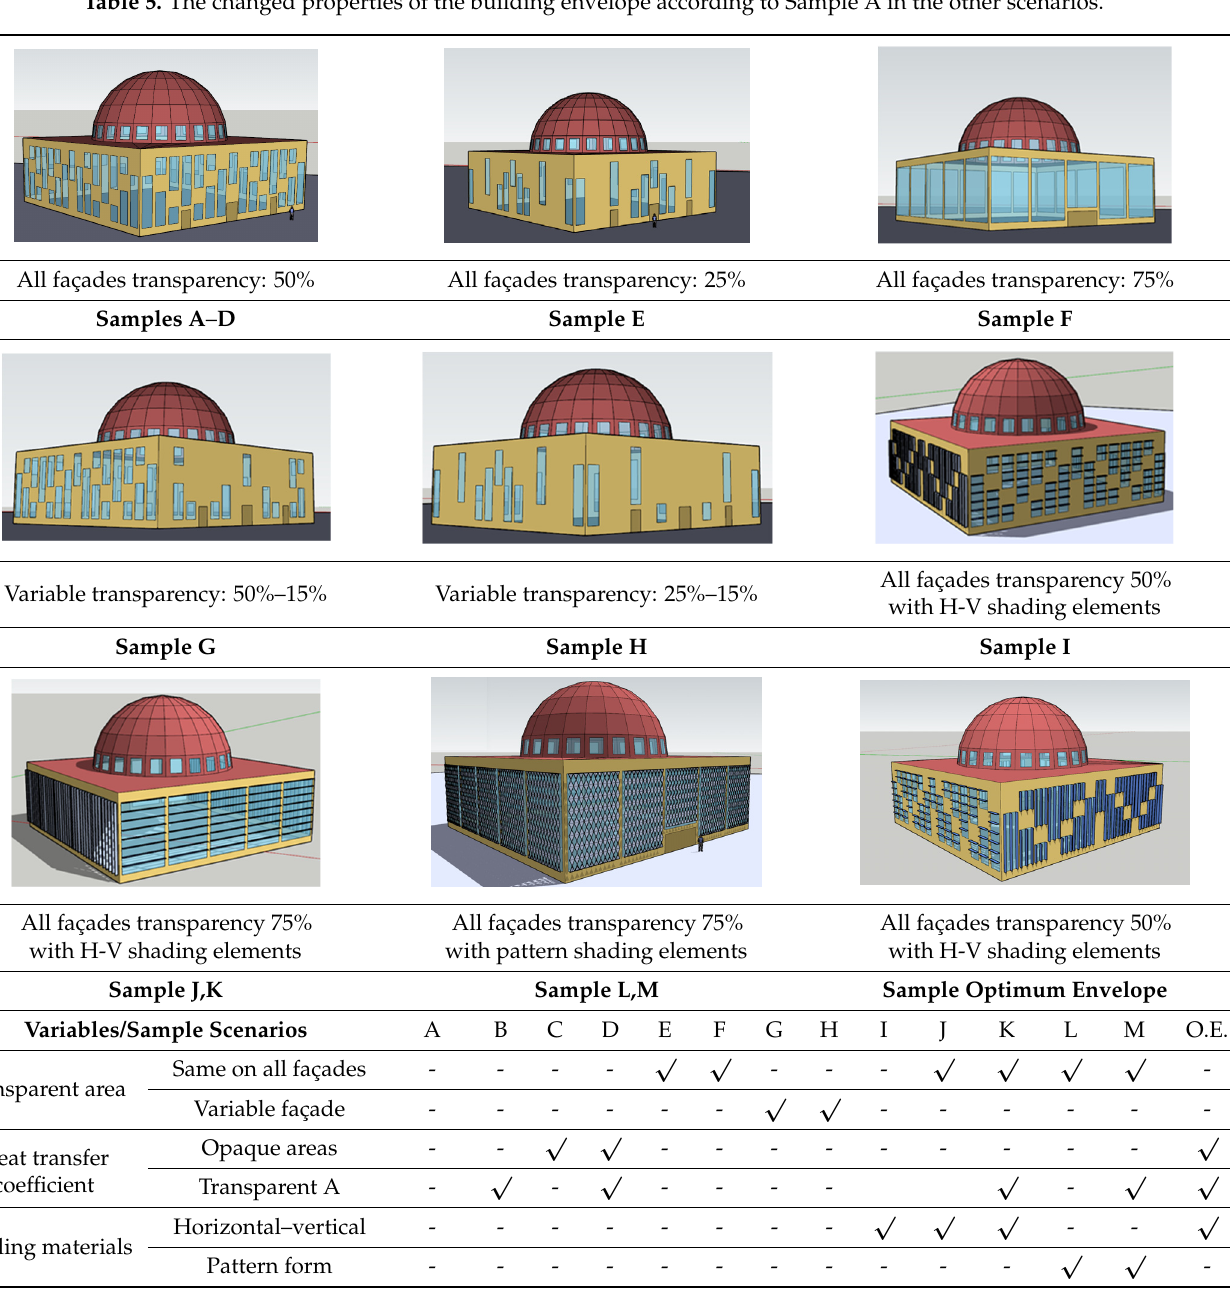
Energies 2021 , 14 , 6597 7 of 17 Table 4. Transparent ratios of building envelope according to directions in scenario types. Table 4. Transparent ratios of building envelope according to directions in scenario types. Table 4. Transparent ratios of building envelope according to directions in scenario types. Table 4. Transparent ratios of building envelope according to directions in scenario types. Table 4. Transparent ratios of building envelope according to directions in scenario types. Table 4. Transparent ratios of building envelope according to directions in scenario types. Table 4. Transparent ratios of building envelope according to directions in scenario types. Table 4. Transparent ratios of building envelope according to directions in scenario types.